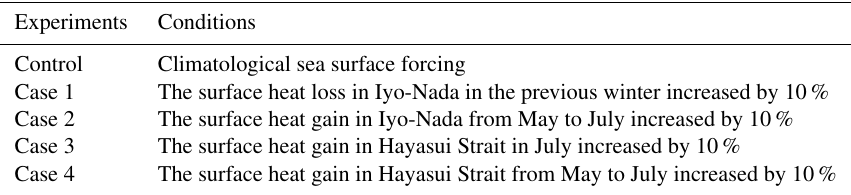
Table 1. List of numerical experiments and